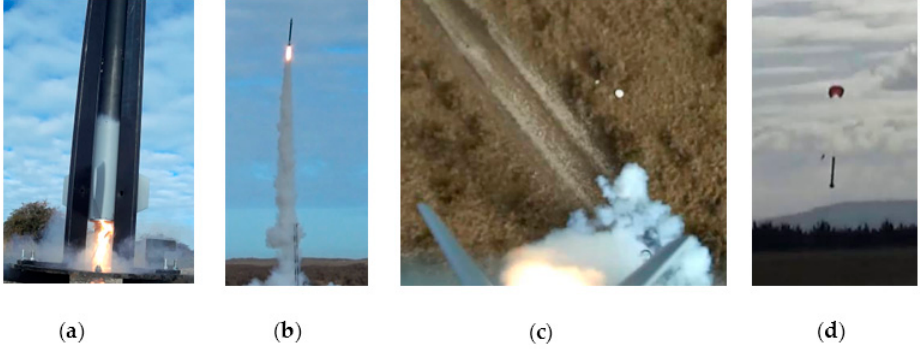
Figure 17. Tasha III launch 1 stills ( a ) ignition; ( b ) take-off; ( c ) onboard video; ( d ) recovery.